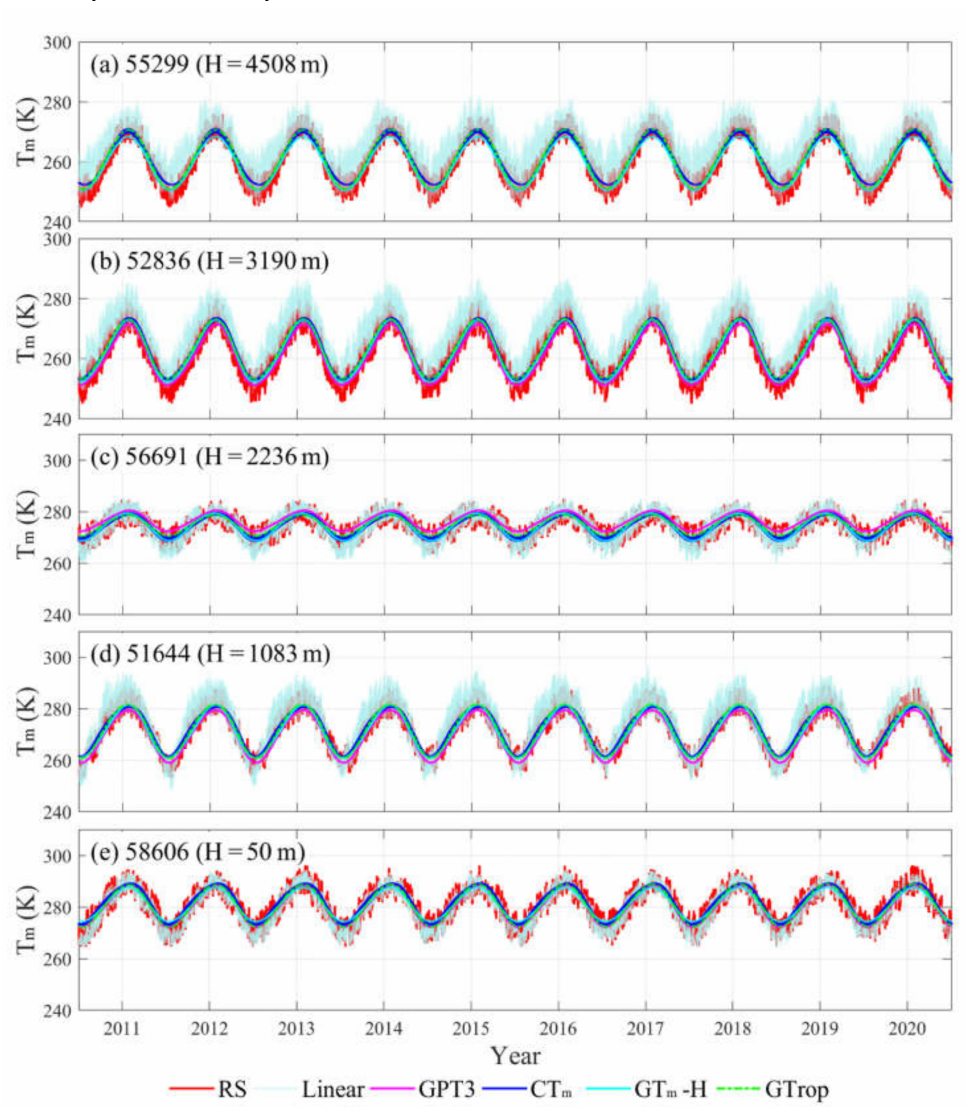
Figure 2. Time series comparison of the five T m models and the RS-derived T m at five stations distributed in different altitudes over the period of 2011 to